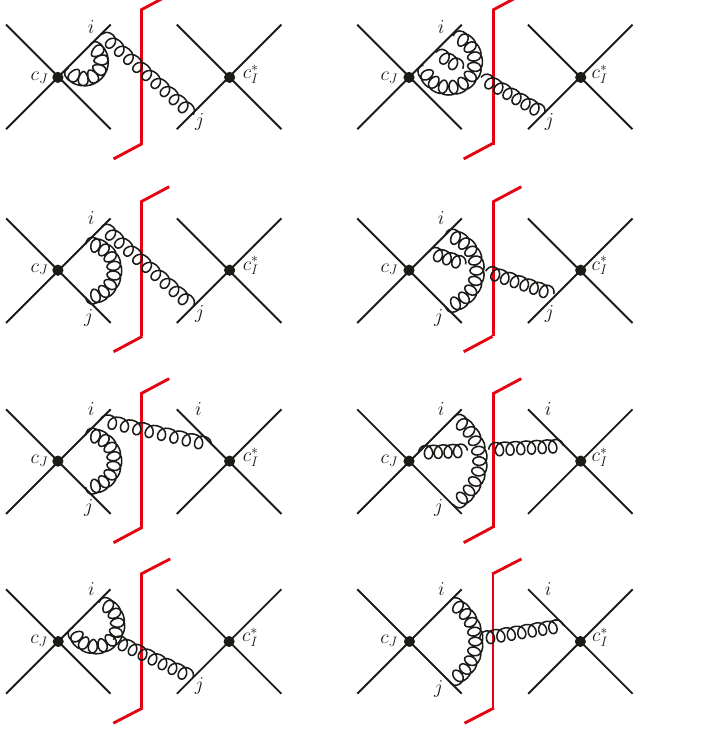
Figure 6 . Two-Wilson-line virtual-real diagrams contributing to the NNLO soft